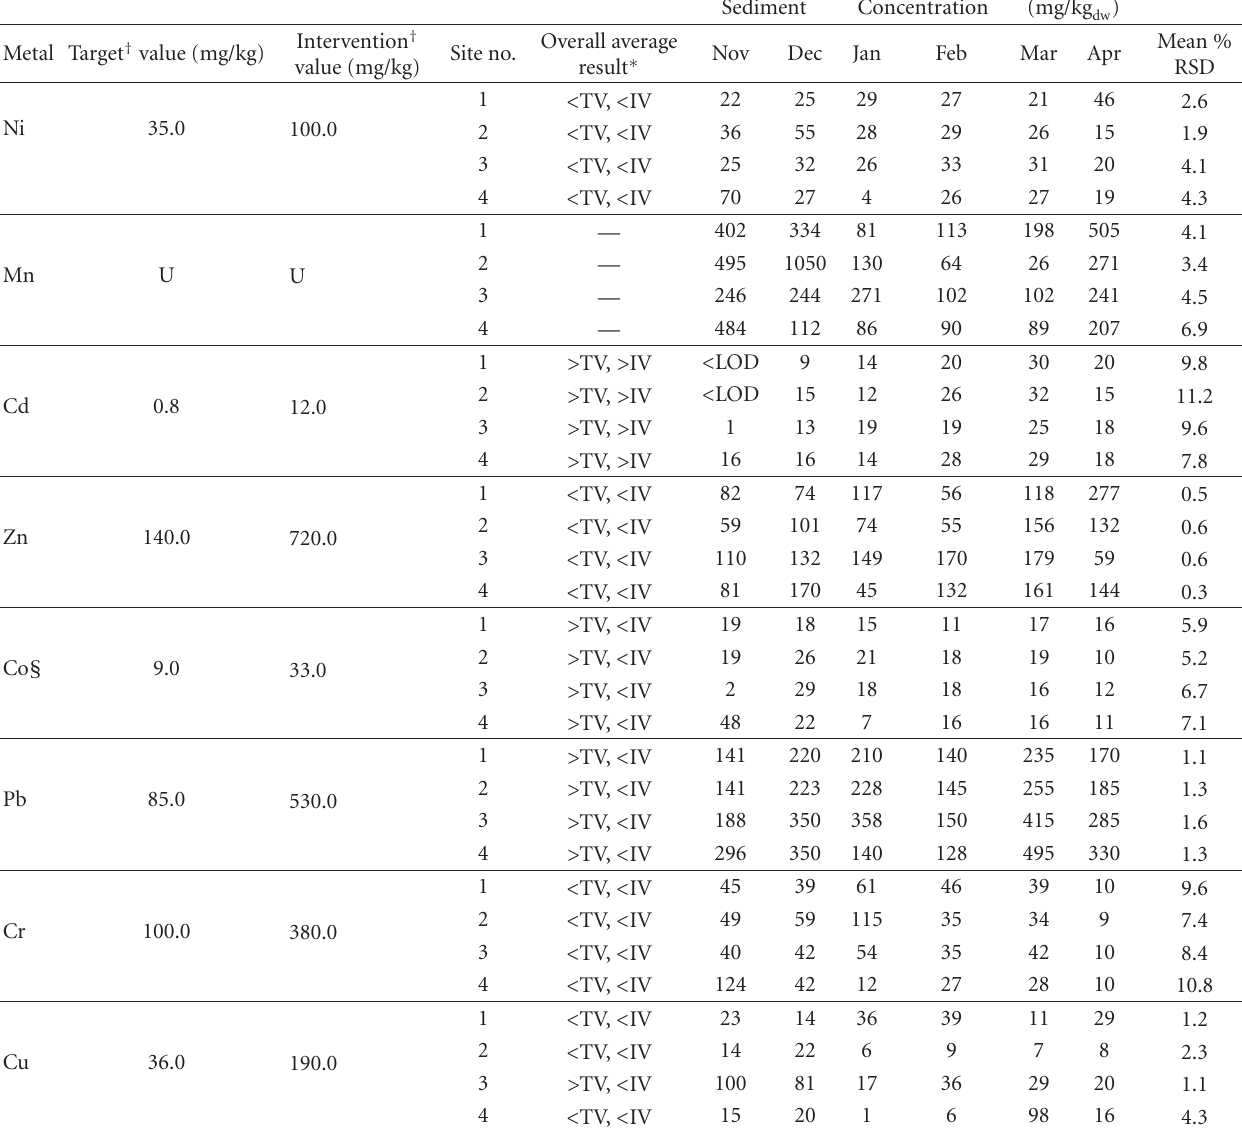
) over a six-month period, 2004-2005. dw Sediment Concentration (mg/kg